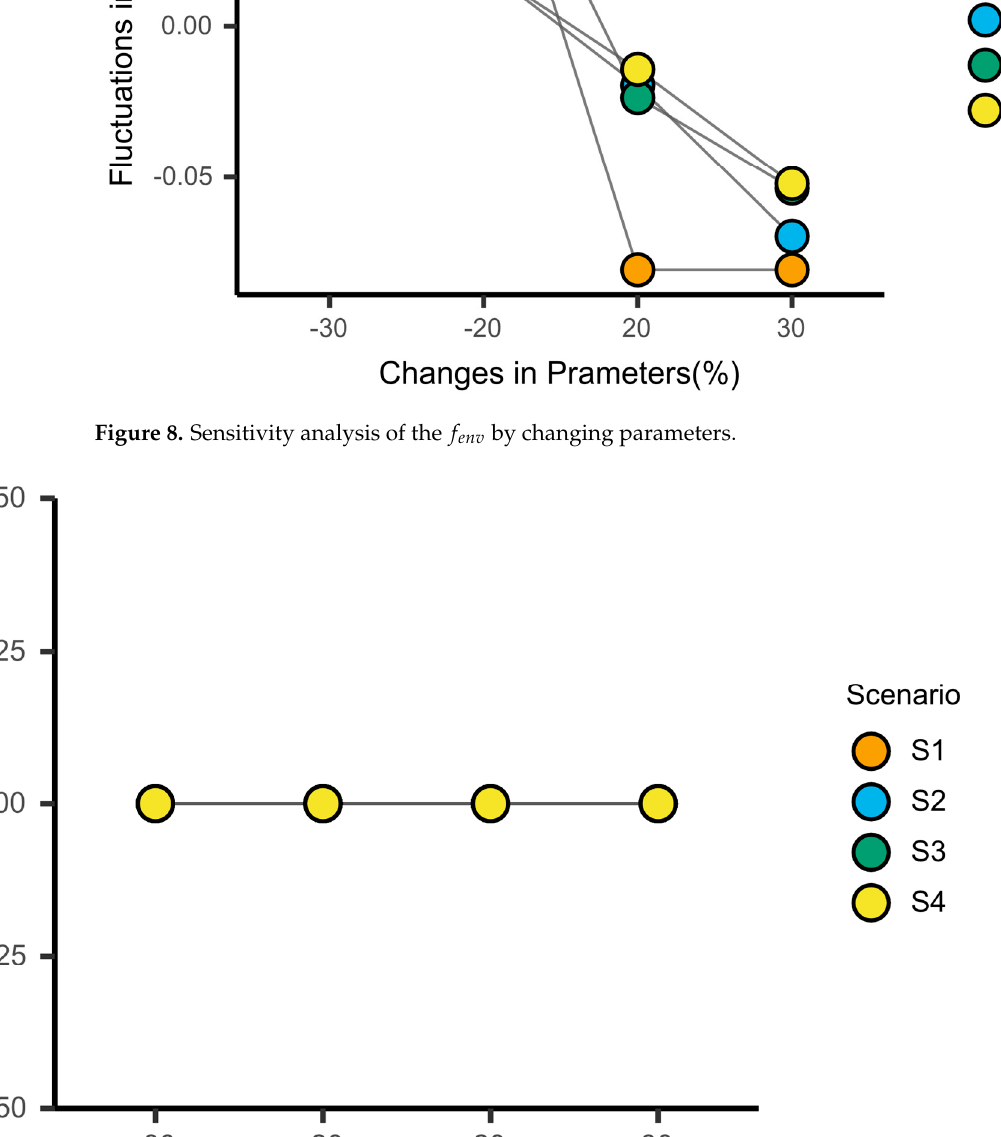
Figure 9. Sensitivity analysis of the f soc by changing parameters.